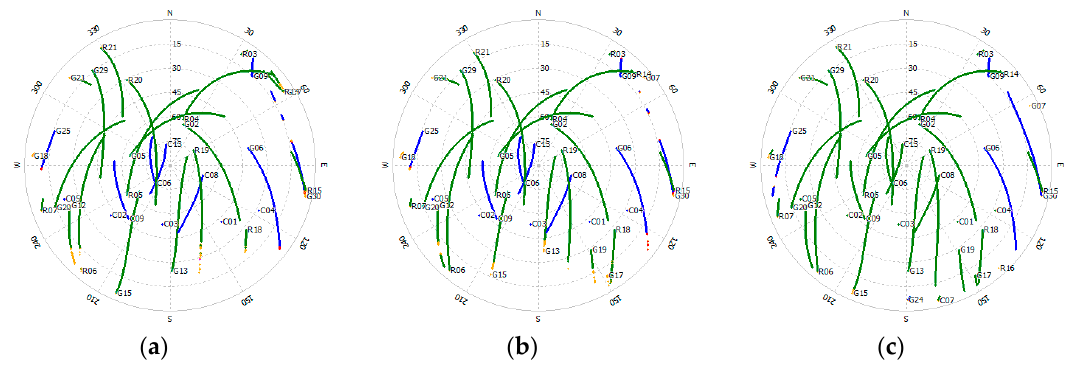
Figure 6. Sky plot of the three sites: ( a ) Site A, ( b ) Site B, ( c ) Site C.